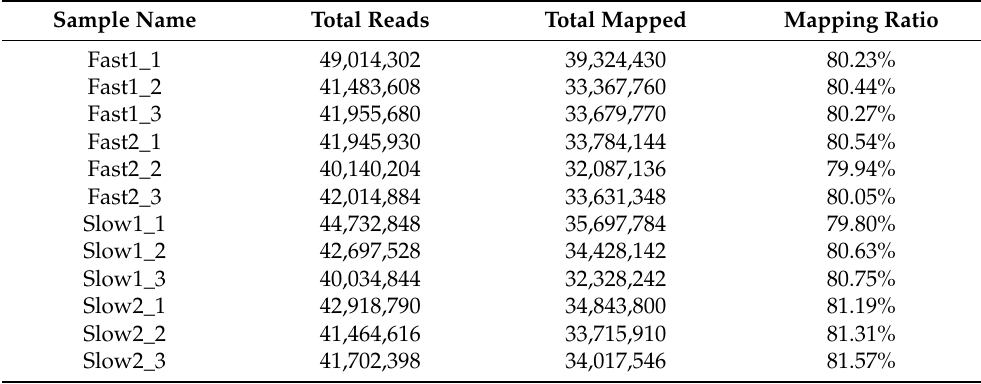
Table 1. Summary of the mapping of transcriptome reads to the reference